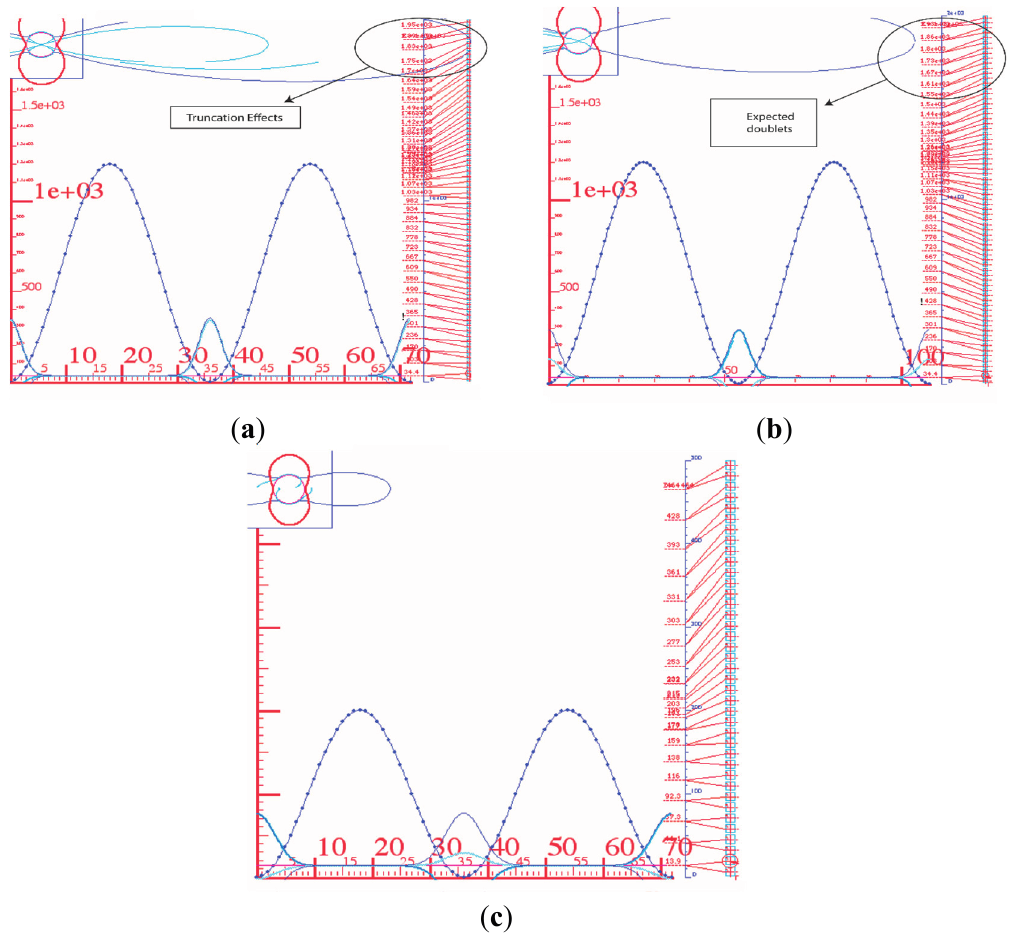
Figure 10. Energy level diagrams. ( a ) High-energy truncation effects occur for a high barrier ( V = 1200 cm − 1 ) and a low truncation value (cid:4666)(cid:1836) reduced for higher truncation values (cid:4666)(cid:1836) ( V = 200 cm − 1 ).